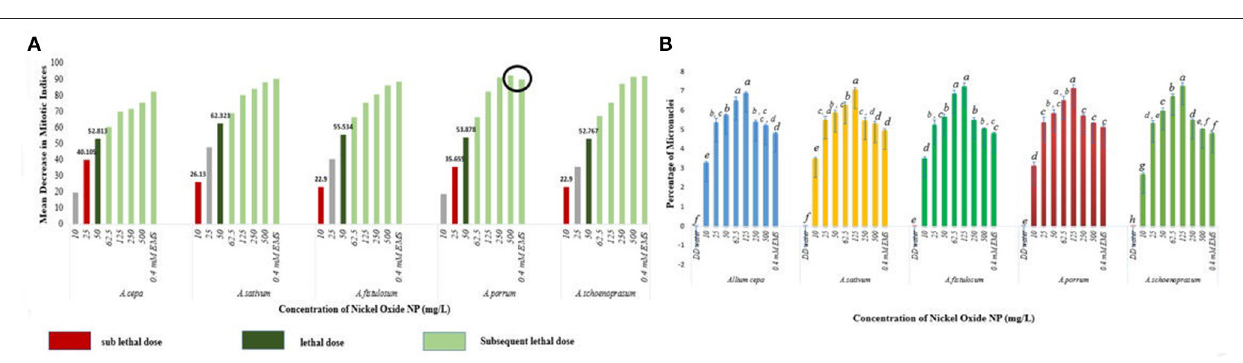
FIGURE 5 | (A) NiO-NP suspension being sub lethal to lethal in every concentration in all the five species of Allium. In A. porrum, 0.4mM EMS shows to be less toxic than 500mg L − 1 NiO-NP suspension; sub lethal dose where MI decreases more than 22% of that of negative control, lethal dose where MI decreases more than 50% of that of negative control; (B) Percentage of micronuclei formation on NiO-NP exposure ( p <